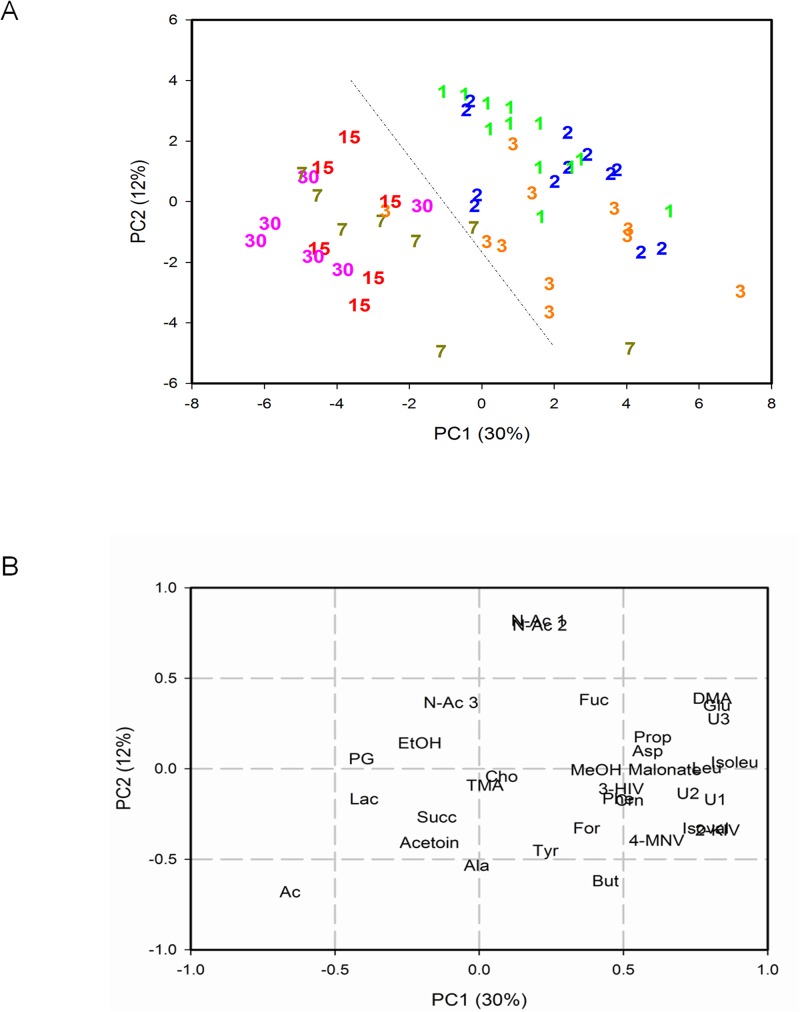
Principal Components Analysis (PCA) of metabolic profiles from 55 CS-delivered newborns.Samples were analysed over the 30 days following birth. Panel A: PC score plot. Panel B: loading plot. The first two components explained 42% of the total variance.